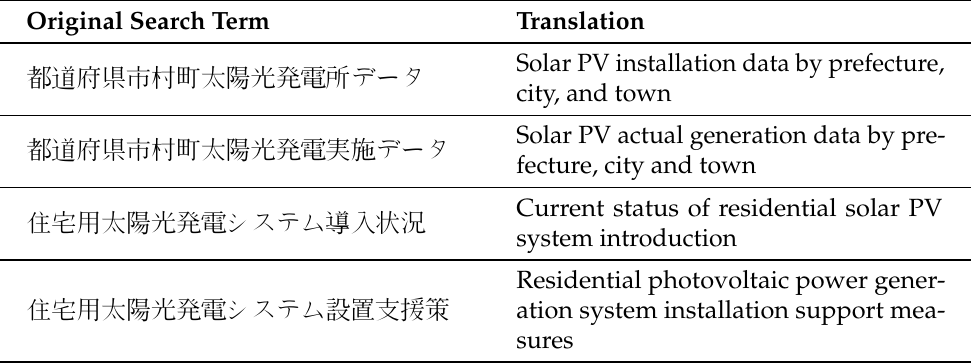
Table 5. Google search terms used to identify solar PV installed capacity data in